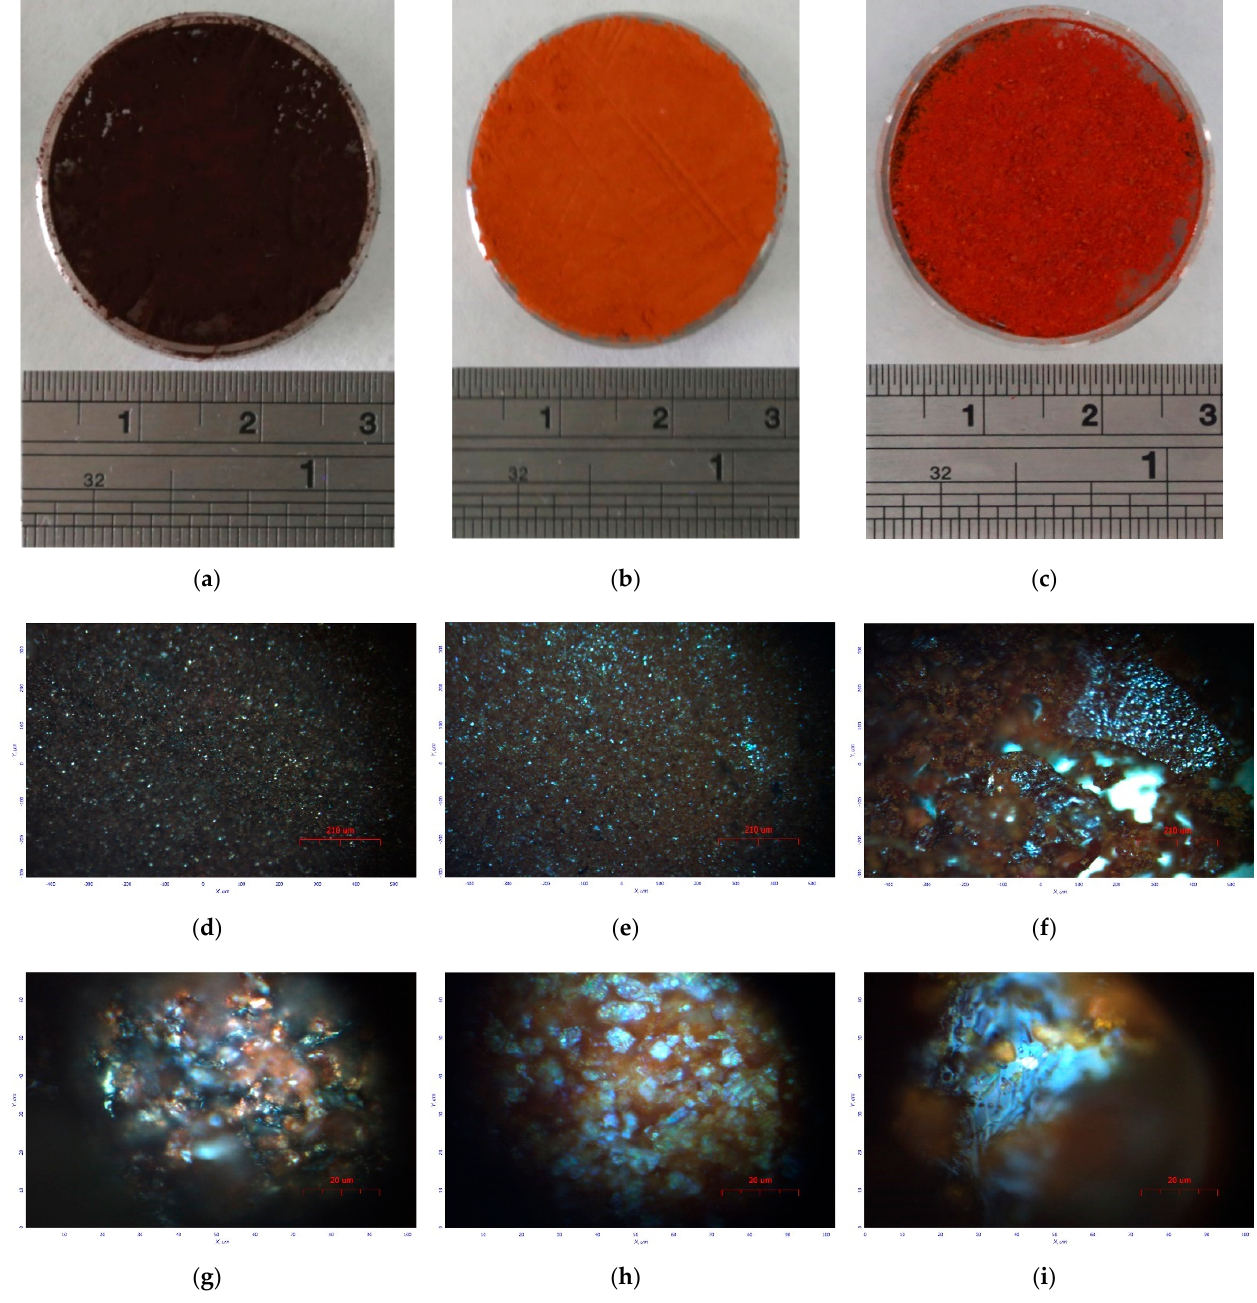
Figure 2. Appearance of synthesized samples and micromorphology of particles: ( a , d , g ) TTDA; ( b , e , h ) TTGA; ( c , f , i ) DNTT. 3,6 ‐ Dinitroamino[1,2,4]triazolo[4,3 ‐ b ][1,2,4,5]tetrazine (DNTT) was synthesized by a well ‐ known method [13].